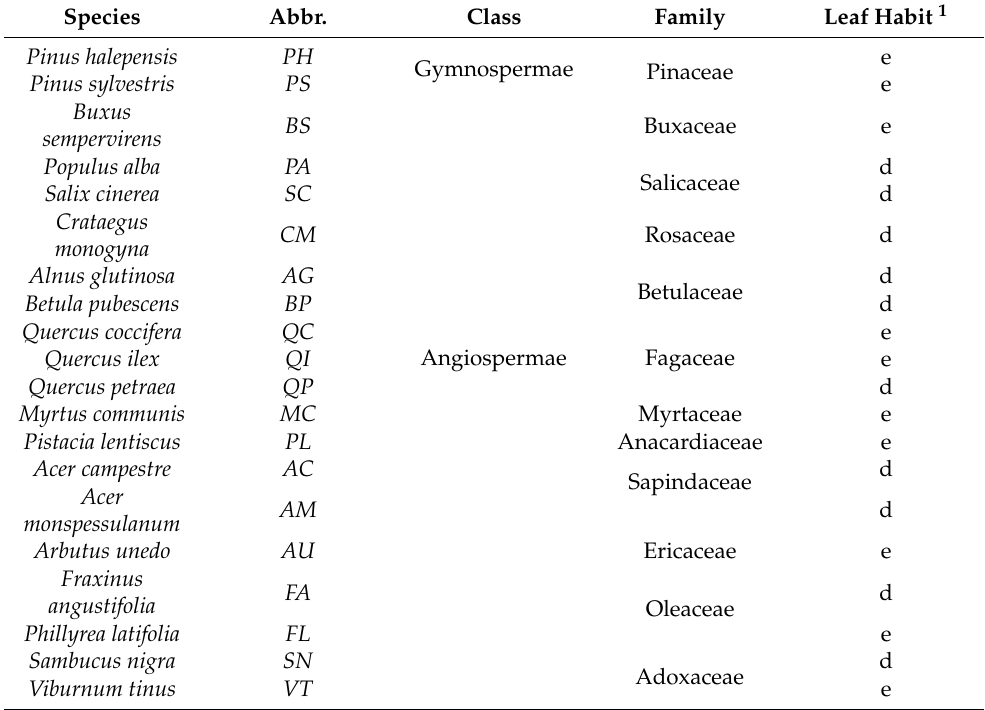
Table 1. Plant species used in the experiment, abbreviations (abbr.), taxa (classes, families) and leaf